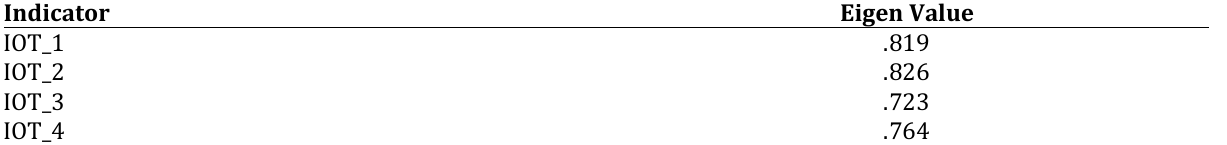
Source : Sample Survey, 2022